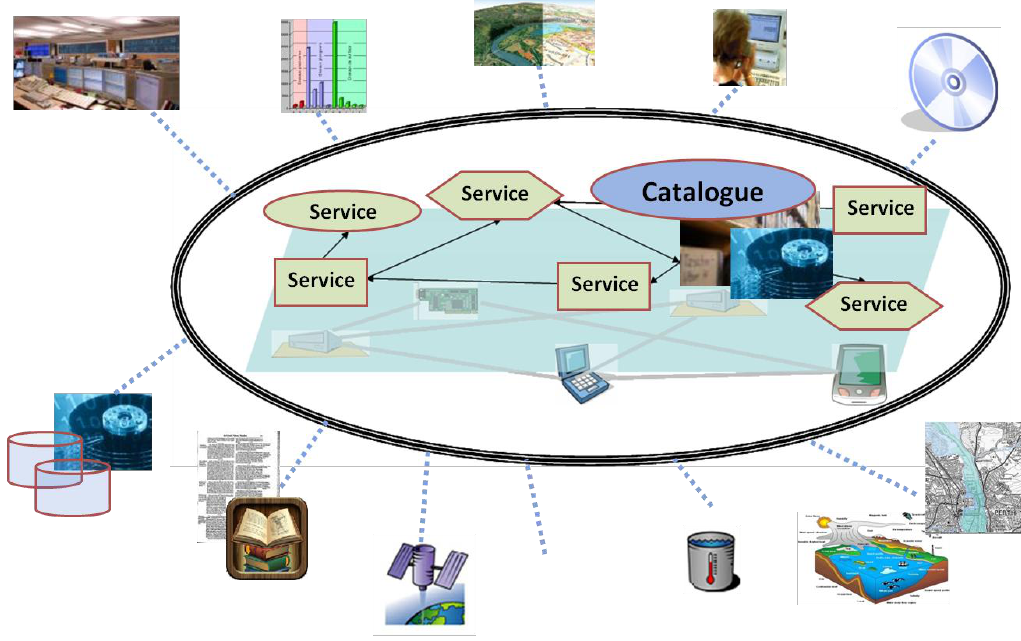
Figure 9. Service infrastructure (from RM-OA [35], slightly